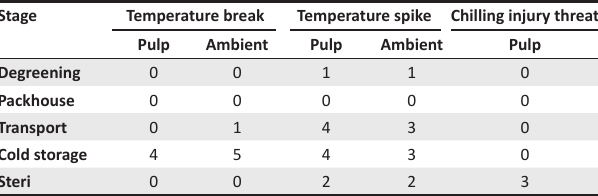
TABLE 6: Number of temperature breaks and spikes per stage. Stage Temperature